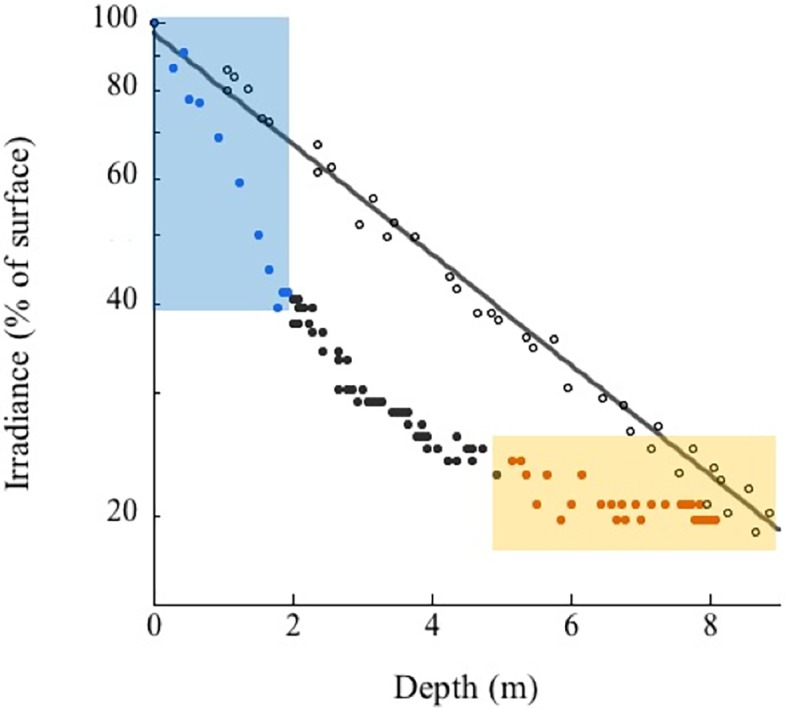
Varadero Reef optical properties.Analyses of the variations in the optical properties of the water column in Varadero Reef (solid circles) indicate the presence of highly stratified water masses. The blue symbols in the blue shaded area highlight the upper layer with Kd values of 0.488 m−1, the black symbols indicate transition region with Kd of 0.19 m−1 whereas the orange symbols in the shaded area indicate the presence of very clear waters with Kd values of 0.041. For comparison the monotonic vertical attenuation for the Rosario Island is presented (open circles) with Kd values of 0.165 m−1.